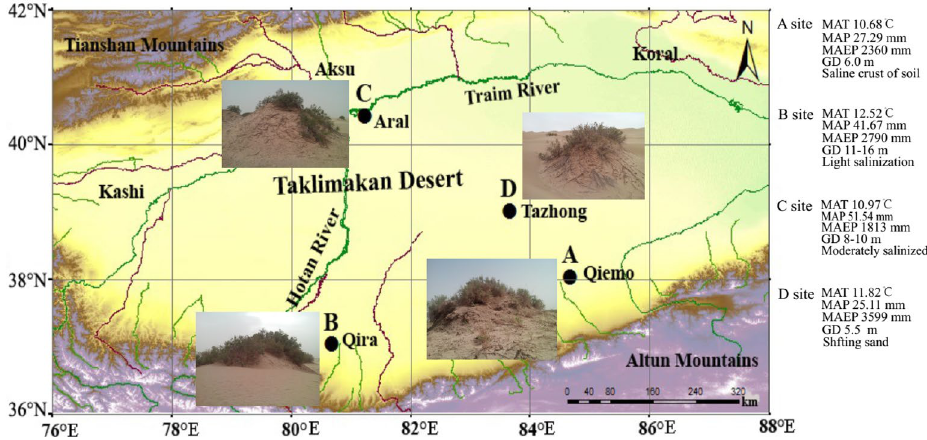
Figure 1. Location map of sampling plots in the Taklimakan Desert (where A, B, C, and D represent different habitats of Tamarix cones. A: Saline desert–alluvial plain of Qiemo; B: oasis–desert ecotone of Qira; C: oasis– desert ecotone of Aral; and D: Sandy desert Habitat of Tazhong. MAT = mean annual temperature; MAP = mean annual precipitation; MAEP = mean annual evaporation; GD = Groundwater depth. The map was created using ArcGIS10.7 software (https:// www. onlin edown. net/ soft/ 11626 54. htm) and Adobe Illustrator (AI) CS5 software (https:// www. onlin edown. net/ soft/ 578049.